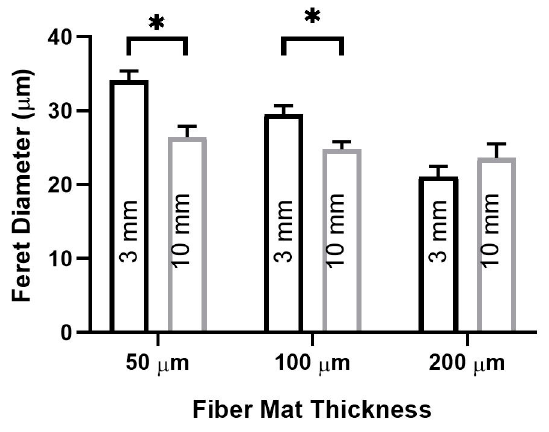
Figure 6. Glioblastoma cell Feret diameter measured on supports with 3 and 10 mm diameter annular gaps supporting EFMs of different thicknesses. A total of 1097 cells were analyzed across at least two independent experiments. Levels connected by a star (*) are statistically significant from each other ( p < 0.05).